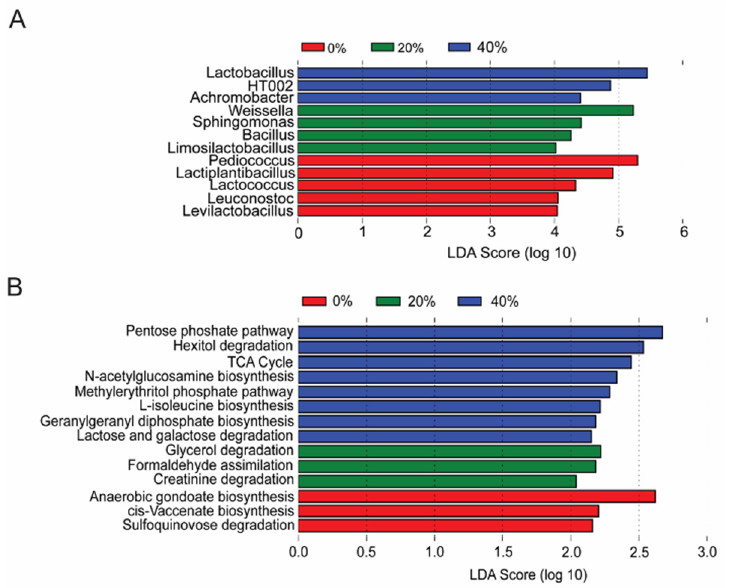
Figure 2. Linear discriminant analysis effect size (LEfSe) of ( A ) bacterial communities and ( B ) MetaCyc pathways for sorghum ensiled with 0, 20, or 40% DM vegetable mix. The effect of treatment ( p ≤ 0.05) was identified if LDA log 10 score ≥ 2.0.